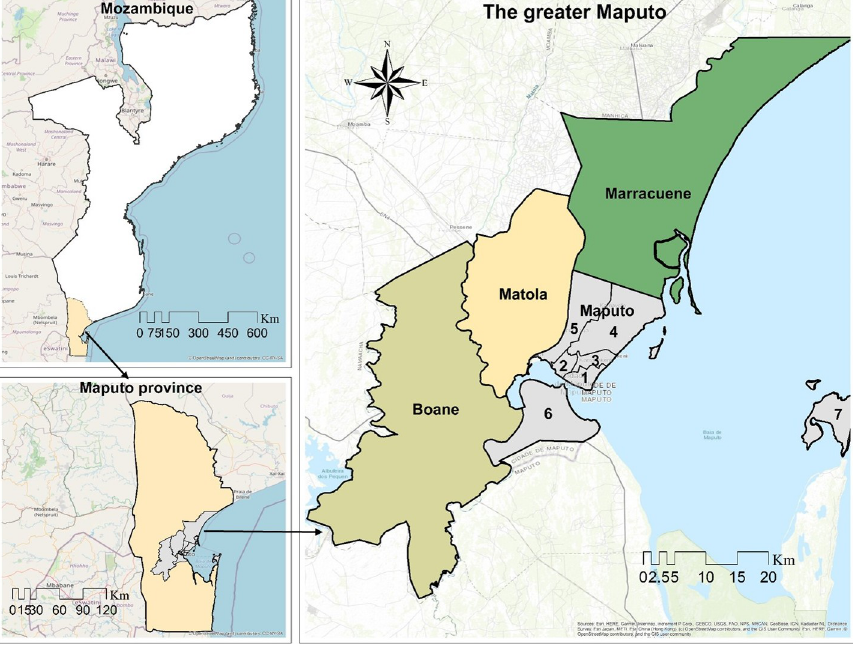
Fig 1. The location of the greater Maputo region. The base maps (World topographic map) were obtained at ArcGIS Online and are the property of ESRI, used herein under license [28]. The copyrights belong to ESRI, but according